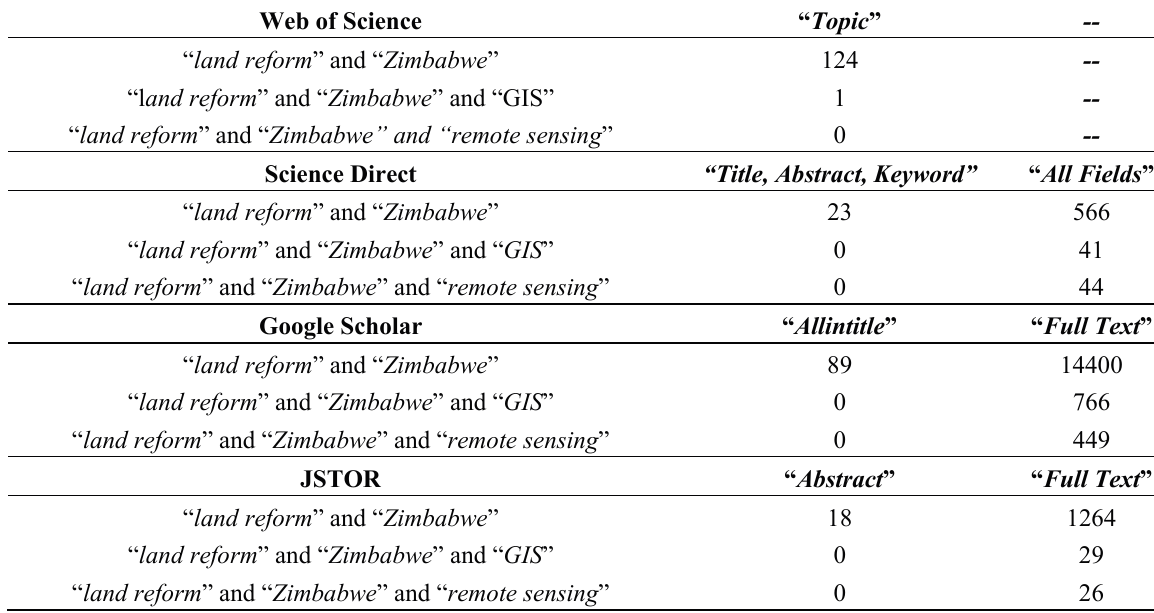
Table 1. Absolute hits of quantitative literature review for respective parameters and databases. Web of Science “ Topic ” -- “ land reform ” and “ Zimbabwe ” 124 -- “l and reform ” and “ Zimbabwe ” and “GIS” 1 -- “ land reform ” and “ Zimbabwe” and “remote sensing ” 0 -- Science Direct “Title, Abstract, Keyword” “ All Fields ” “ land reform ” and “ Zimbabwe ” 23 566 “ land reform ” and “ Zimbabwe ” and “ GIS